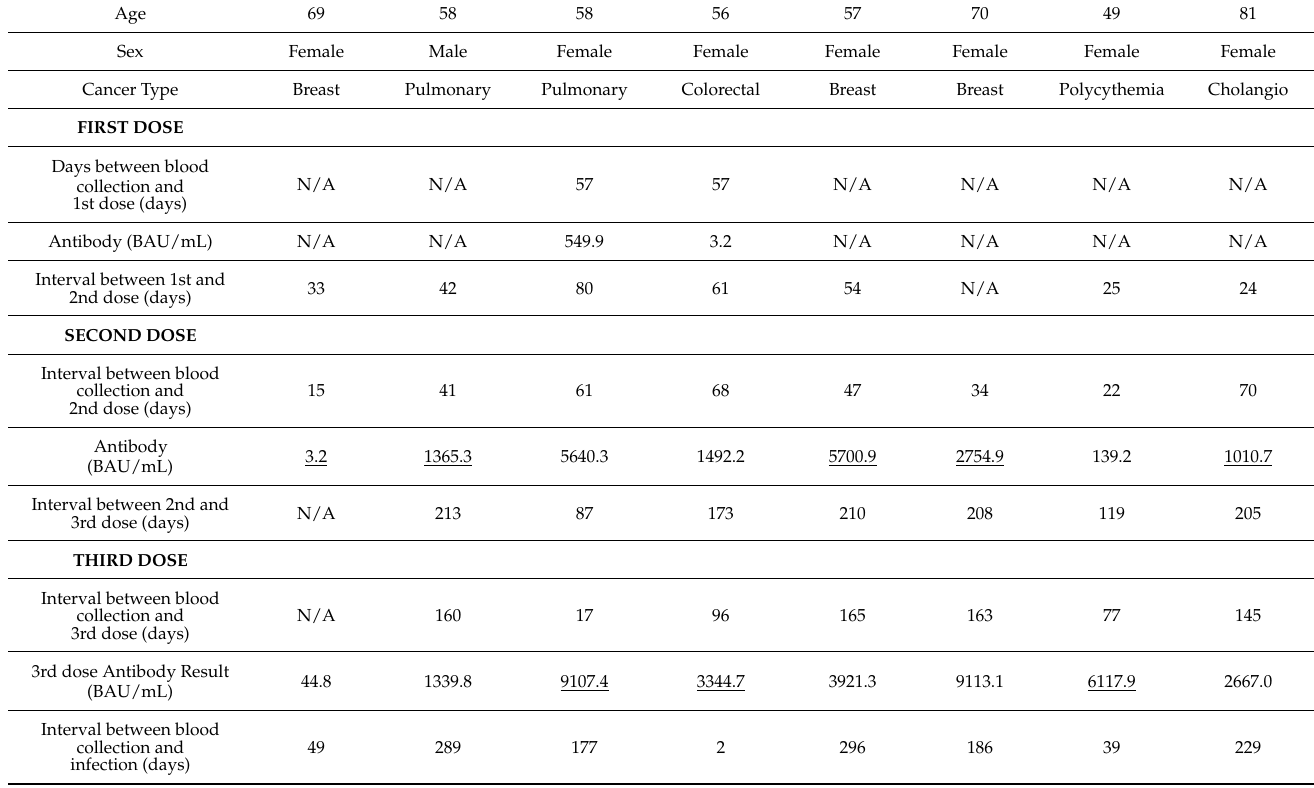
Table 2. Characteristics of eight representative breakthrough cases confirmed by